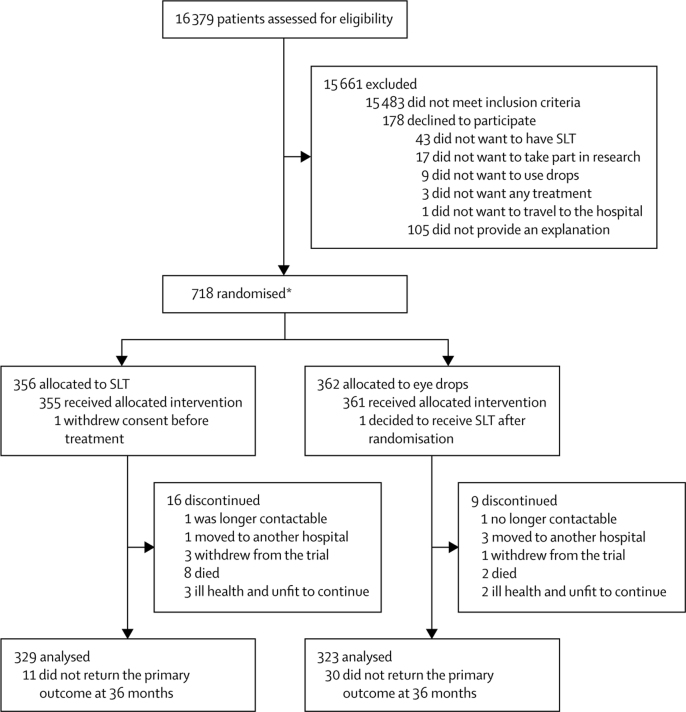
Trial profileSLT=selective laser trabeculoplasty. *Two patients were randomised twice due to computer failure: one was initially randomised to medication but was subsequently randomised to, and received, SLT. The other was initially randomised to SLT but was subsequently randomised to, and received, medication. These patients are included in the figure according to their second randomisations. In addition, four other patients who did not meet the eligibility criteria (and could not receive treatment) were randomised in error. These patients were subsequently removed from the study and are not included in the total randomised.